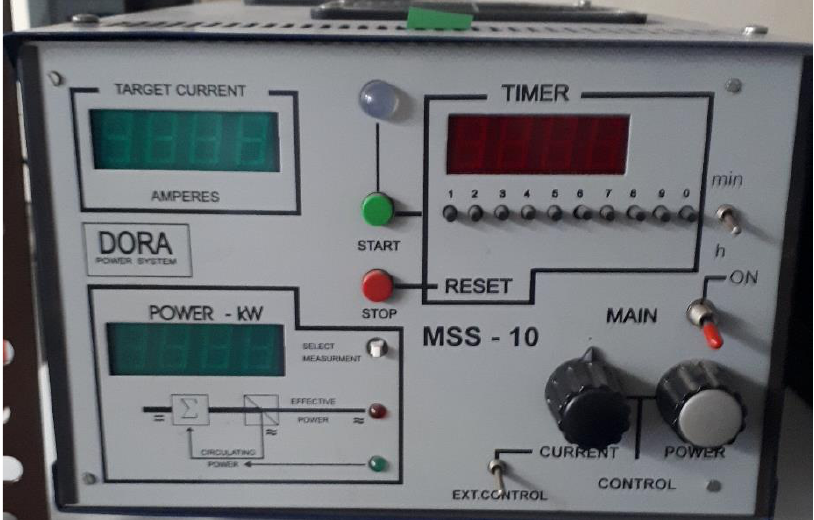
Figure 4. Impulse electric power supply.